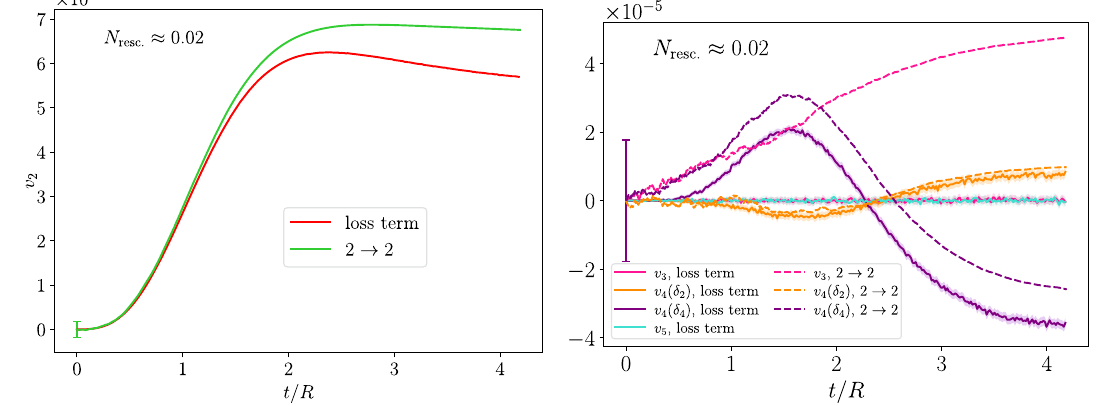
Fig. 14 Time dependence of anisotropic flow harmonics for the ini- tial geometric profile (D1) in systems with N resc . ≈ 0 . 02. Left: v 2 for δ 2 = 0 . 15 (green: numerical simulations, red: semi-analytical approach).Right: v 3 for δ 3 = 0 . 15(magenta), v 4 (orange:for δ 2 = 0 . 15,